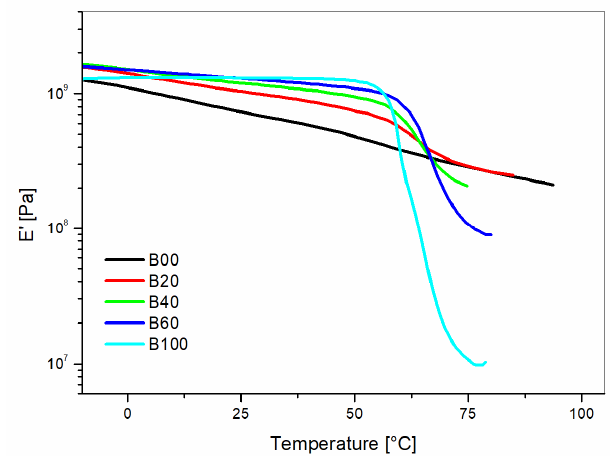
Figure 4. Storage modulus (E’) versus temperature curves for unreinforced blends of PP/Liquid Wood as a function of the Liquid Wood (LV)